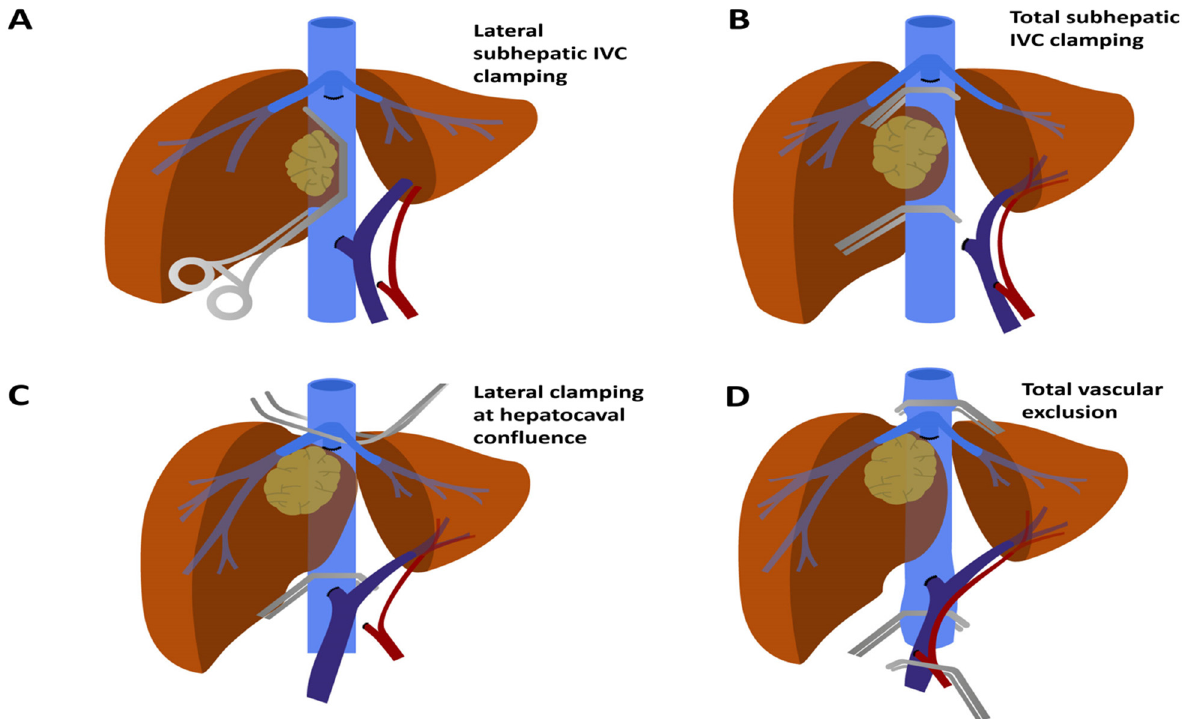
Figure 1. Different IVC clamping strategies depending on infiltration site. ( A ) Lateral IVC clamping below hepatocaval confluence: this strategy can be readily advantageous when involvement is <60–120° circumferentially and <2–3 cm longitudinally. ( B ) Total IVC clamping below hepatocaval confluence: this permits venous return from the liver and does not require hepatic ischaemia ( C ) Side clamping at hepatocaval confluence is a strategy to permit venous return from one side of the liver, despite “very high” neoplastic infiltration. ( D ) Total vascular exclusion necessitates complete IVC clamping above the hepatocaval confluence, concurrent Pringle manoeuvre and hepatic ischemia. Abbreviations: IVC, inferior vena cava.